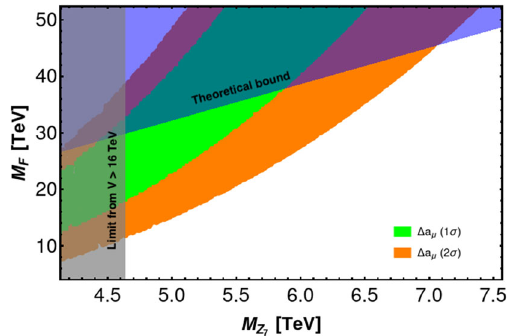
Fig. 5 Allowed parameter region for muon-like heavy fermion mass M F vs. neutral gauge boson mass M Z (orange) band corresponds to (cid:5) a μ within 1 σ (2 σ ). The blue band rep- resents the exclusion region from theoretical bound ( M F < 6 . 43 M Z while the gray region corresponds to the exclusion limit obtained by demanding the trinification scale V (cid:2) 16